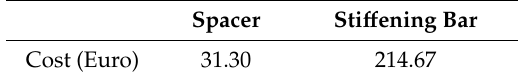
Table 7. The processing cost for a spacer and sti ff ening